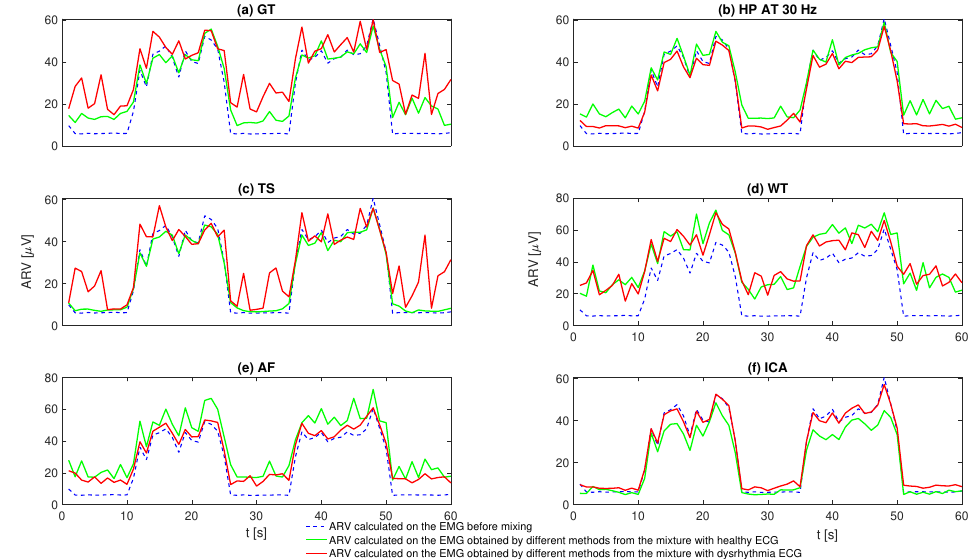
Figure 6. Example of the ARV results calculated from the EMG signals obtained by different ECG removal methods: ( a ) ARV results by GT; ( b ) ARV results by HP; ( c ) ARV results by TS; ( d ) ARV results by WT; ( e ) ARV results by AF; ( f ) ARV results by ICA.